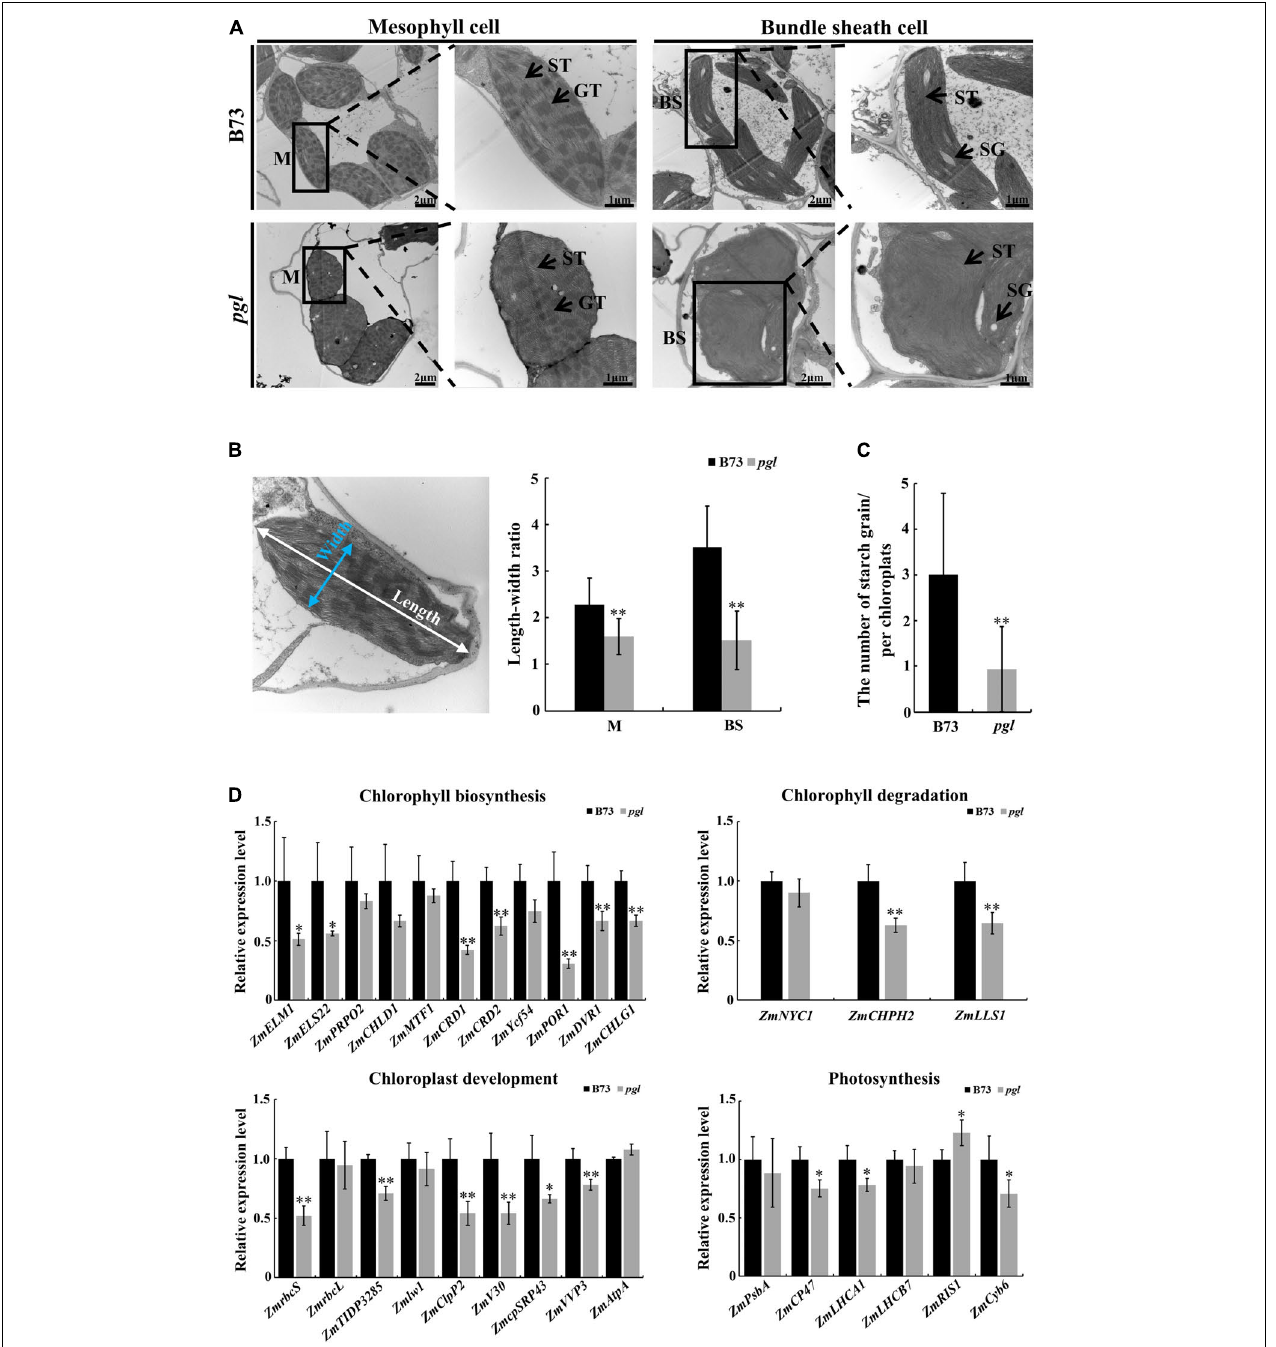
FIGURE 6 | Ultrastructure observation of chloroplasts and expression pattern analysis between B73 and pgl . (A) The ultrastructure of chloroplasts in mesophyll cells and bundle sheath cells between B73 and pgl . M, mesophyll cell; BS, bundle sheath; ST, stroma thylakoid; GT, grana thylakoid; SG, starch grain. Three biological replications were performed. (B) The length-width ratio of chloroplasts was compared in mesophyll cells and bundle sheath cells between B73 and pgl . Data are presented as the means ± SD ( n = 15). (C) The number of starch grains was counted in chloroplasts of bundle sheath cells between B73 and pgl . Data are presented as the means ± SD ( n = 16). (D) qRT-PCR analysis of genes associated with chlorophyll biosynthesis, chlorophyll degradation, chloroplast development and photosynthesis. Data are presented as the means ± SD ( n = 4). Asterisks represent significant differences between B73 and pgl detected by independent sample T -test ( ∗ P < 0.05, ∗∗ P <